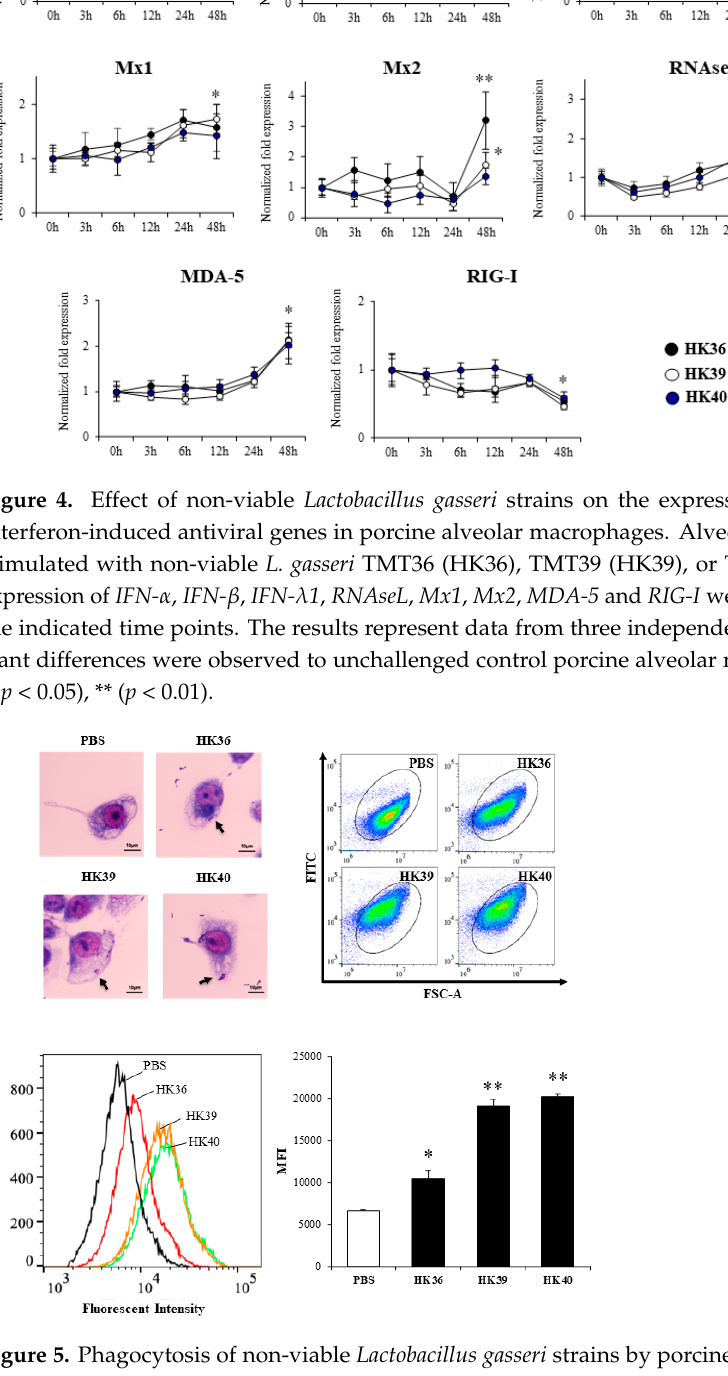
Figure 5. Phagocytosis of non-viable Lactobacillus gasseri strains by porcine alveolar macrophages. Alveolar macrophages were stimulated with non-viable L. gasseri TMT36 (HK36), TMT39 (HK39), or TMT40 (HK40) and phagocytosis was evaluated by flow cytometry and microscopic analysis. The results represent data from three independent experiments. Significant differences were observed when compared to control porcine alveolar macrophages treated with PBS. * ( p < 0.05), ** ( p < 0.01).